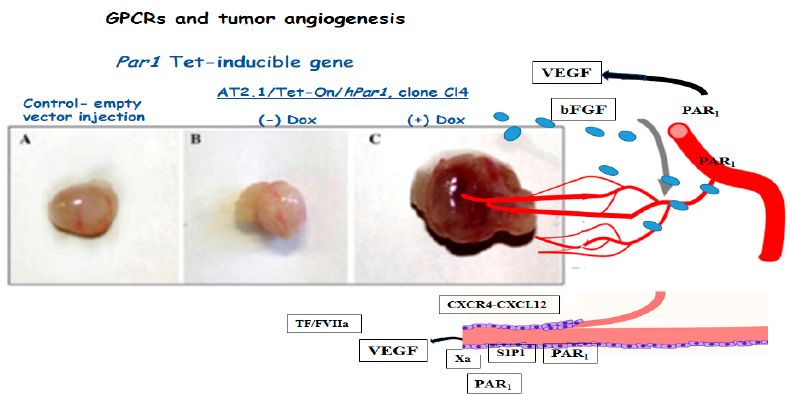
Figure 2. Inducible Par1 expression in rat prostatic carcinoma increases tumor mass and angiogenesis. AT2.1/Tet-On/ hPar1 clone Cl4 cells and control transfected ( A ) (vector only) cells were injected into rats, subcutaneously. Animals were maintained for 2 weeks with regular drinking water ( B ) or drinking water supplemented with Dox ( A , C ). After 2 weeks, tumors were excised and evaluated for weight and color. Tumors shown were from animals injected with the following: ( A ) control transfected cells, nourished with Dox for 2 weeks; ( B ) AT2.1/Tet-On/ hPar1 , clone Cl4; ( C ) AT2.1/Tet- On/ hPar1 clone Cl4, nourished with Dox for 2 weeks.